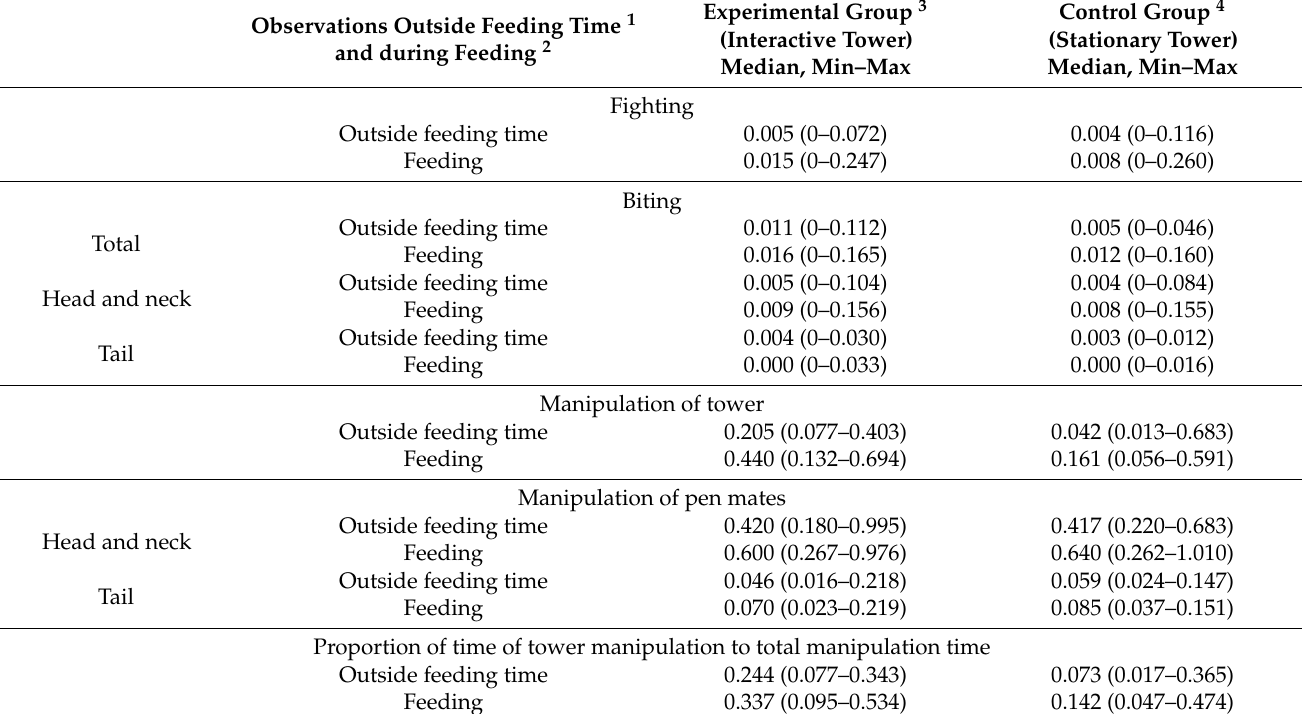
Table 5. Behavioural parameters evaluated by analysis of retrospective video recordings. Average number of specific behaviours per pig in one pen within five minutes are shown (median and range of data from all pens and all evaluated days within the respective groups).